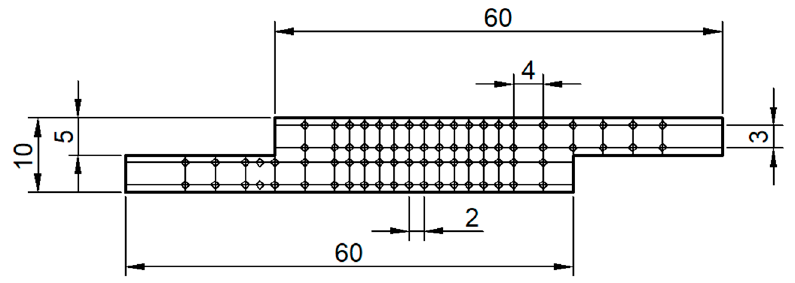
Figure 5. Schematic of measurement points of Vickers hardness profiles on the cross-section per- pendicular the welding direction (all dimensions in mm).